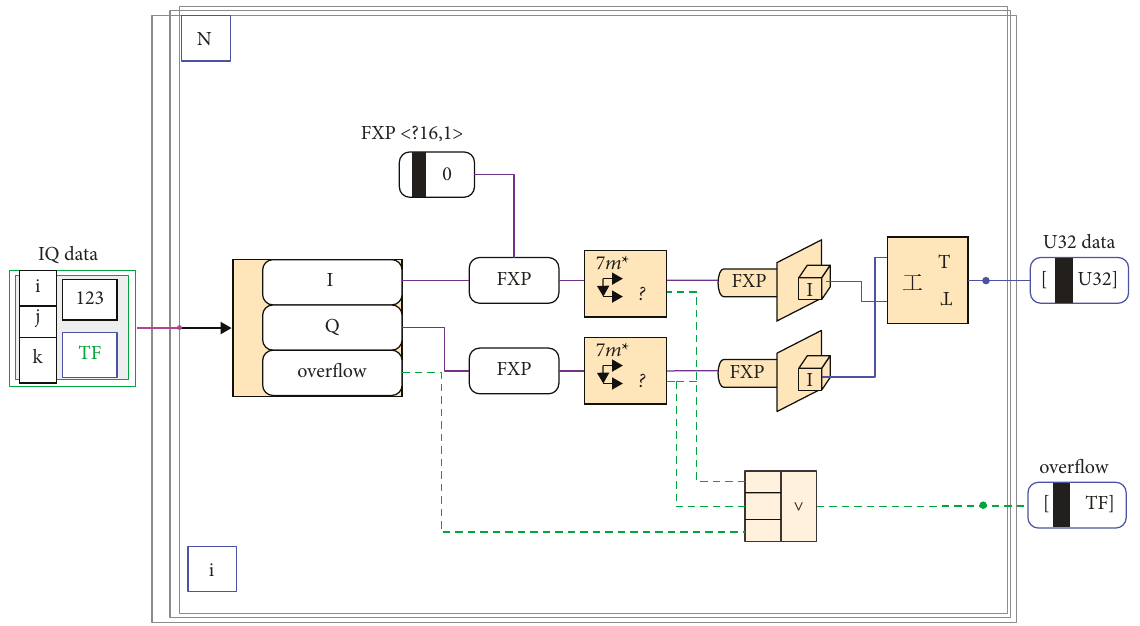
Figure 9: The process of converting an IQ signal into a real